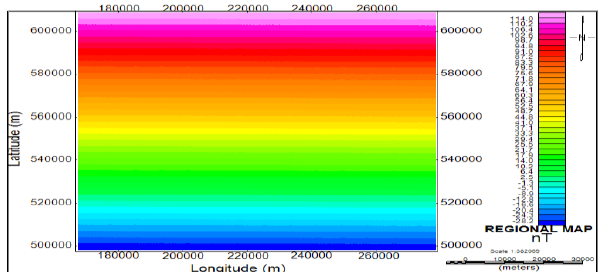
Figure 4: Regional Magnetic Intensity Map of the study area